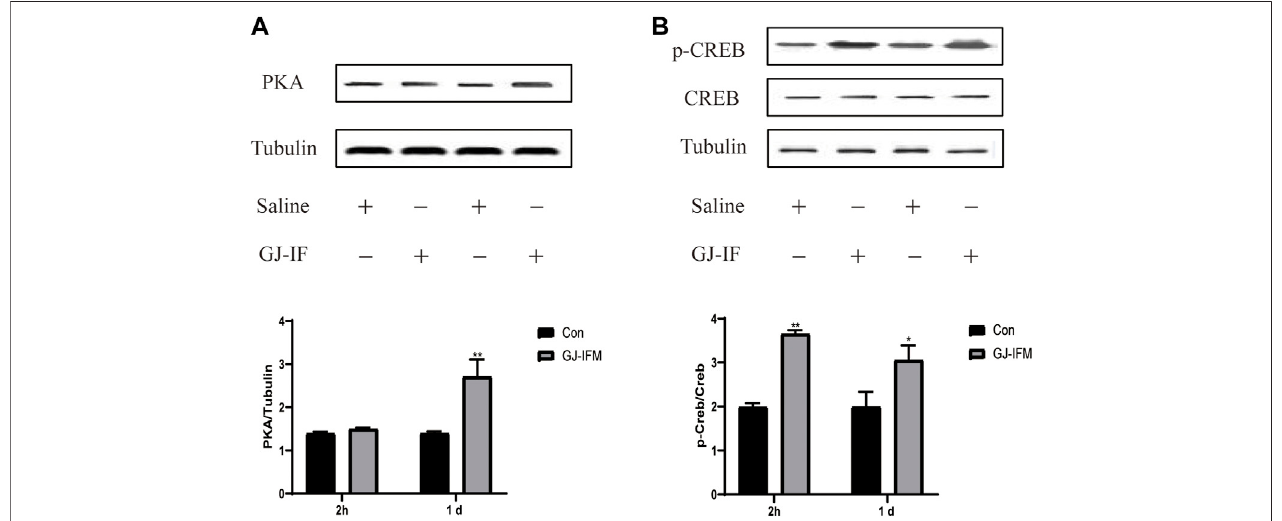
FIGURE 9 | p-CREB activated at 2 h and 1 d after GJ-IFM treatment, while PKA activated at 1 d. (A) The expression of PKA signi fi cantly enhanced in the hippocampus at 1 d after GJ-IFM administration, but not 2 h. t -test, 2 h: p > 0.05, 1 d: ** p < 0.01; control vs . GJ-IFM. (B) The expression of p-CREB signi fi cantly enhanced in the hippocampus at 2 h and 1 d after GJ-IF administration. t -test, 2 h: ** p < 0.01, 1 d: * p < 0.05; control vs . GJ-IFM.